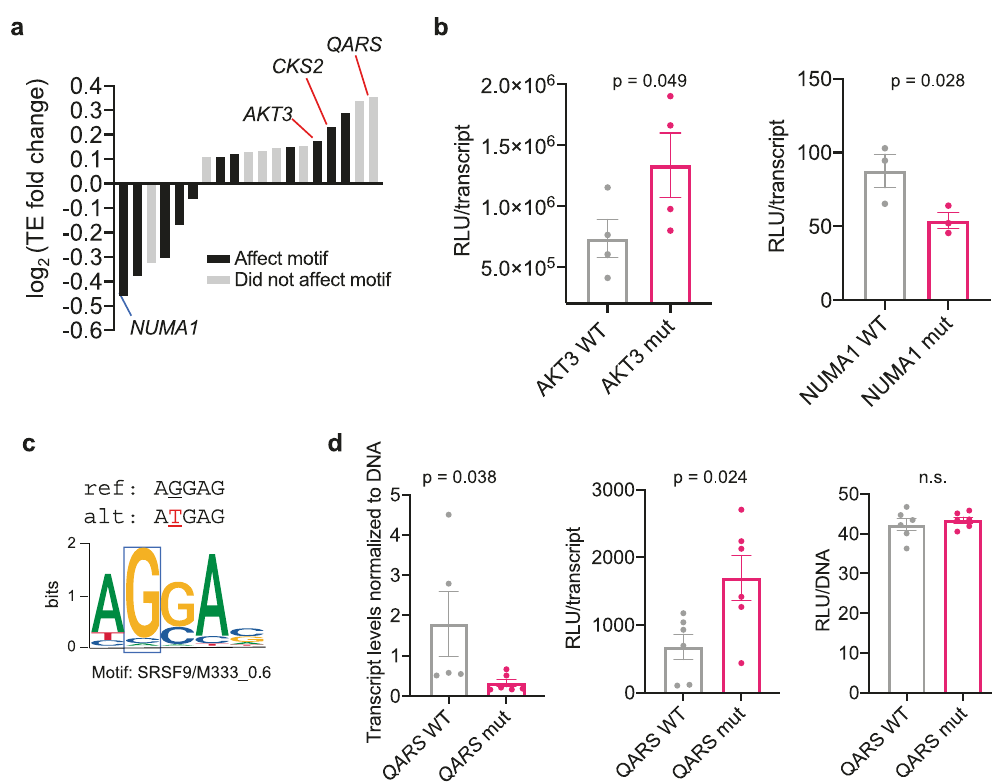
Fig. 5 PLUMAGE uncovers somatic 5 ′ -UTR mutations that affect mRNA translation ef fi ciency and multiple layers of gene expression. a 5 ′ -UTR mutations that signi fi cantly affect mRNA translation ef fi ciency (Mann – Whitney U test, FDR < 0.1) and magnitude fold change compared to unmutated 5 ′ - UTRs (Supplementary Data 6e). A proportion of mutations impact known RNA-binding protein-binding motifs, indicated by black bars. b Validation of 5 ′ - UTR mutations in AKT3 (chr1: 244006547, C -> T) and NUMA1 (chr11: 71780891, C -> A) by luciferase assay. Each WT (represented in gray) or mutant (represented in pink) construct was separately transfected into PC3 cells and assayed for luciferase activity and luciferase mRNA expression after 24 h. Luciferase activity (RLU) was normalized to the amount of luciferase transcript in each transfection to determine translation ef fi ciency ( n = 4 biological replicates for AKT3 WT and mutant, mean ± s.e.m. Student ’ s t test; n = 3 biological replicates for NUMA1 WT and mutant, data are presented as mean ± s.e.m., one-sided Student ’ s t test). c The C -> A 5 ′ -UTR mutation in NUMA1 at position chr11: 71780891 abrogates an existing SRSF9 RNA-binding protein motif. Mutated nucleotide is represented in red. d The 5 ′ -UTR mutation in QARS (chr3: 49142179, G -> A) shows signi fi cant changes in both transcript levels and translation ef fi ciency, not attributable to the amount of DNA transfected. Each QARS 5 ′ -UTR WT (represented in gray) and mutant